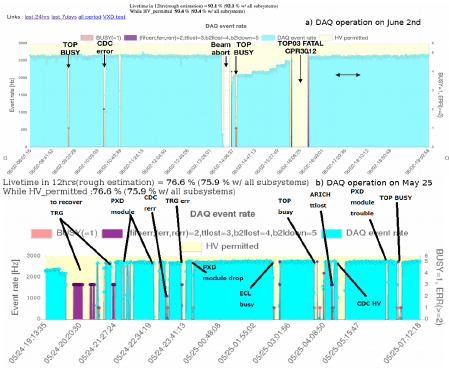
Figure 8. DAQ accepted rate as a function of time. The upper figure shows the operation on a good day, where DAQ e ffi ciency is 93.4%. The lower figure shows that on a bad day, where the e ffi ciency is